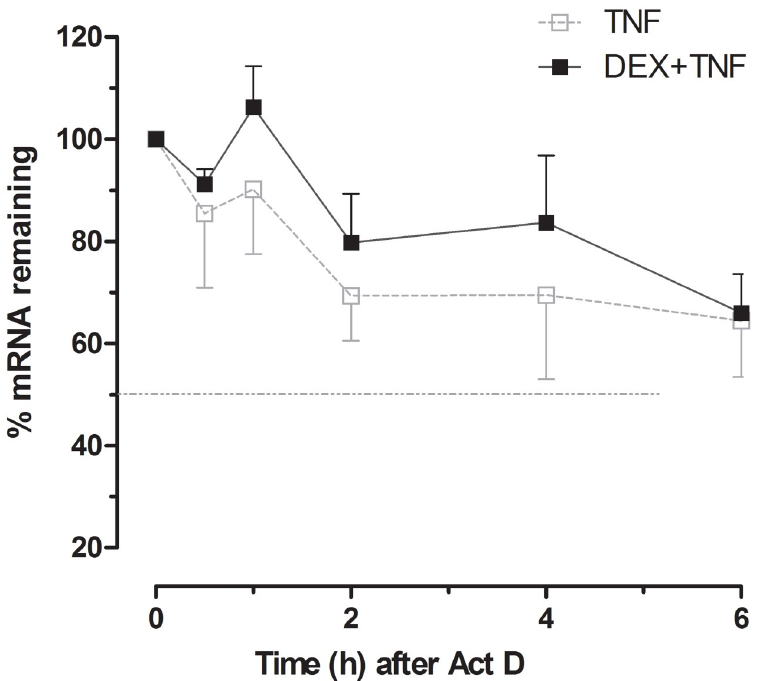
Fig 5. Effects of DEX on PTX3 mRNA stability. Growth-arrested HASMC were treated with TNF (10ng/ml) in the absence or presence of DEX (10 − 6 M) for 12 h. Cells were then washed and incubated with Act D (5 μ g/ml). Total RNA was extracted and quantified by real-time PCR. Results are expressed as % mRNA remaining over time after Act D treatment from 3 different primary HASM cell lines isolated from 3 different donors.